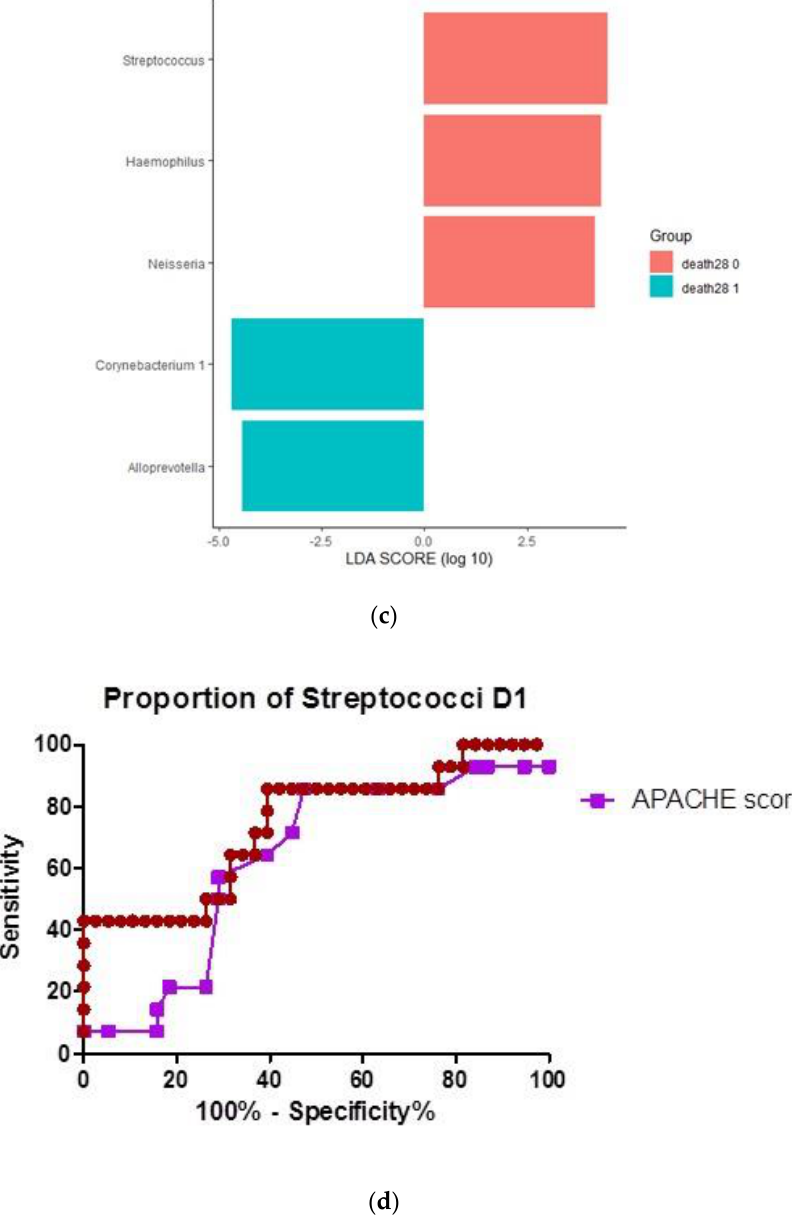
Figure 5. Association between respiratory microbiome and 28-day mortality in intubated patients with pneumonia. ( a ) Shannon diversity index and Simpson index. ( b ) Bray–Curtis distance between samples, shown as a PCoA two-dimensional map. Each dot represents one sample. ( c ) Histogram of unique biomarker bacteria detected based on the LDA effect size (>2.5-fold). ( d ) ROC curve for the association between 28-day survival and the relative abundance of Streptococcus in ETA at day 1.LDA, linear discriminating analysis; ROC, receiver operating characteristics; ETA, endotracheal aspirate.